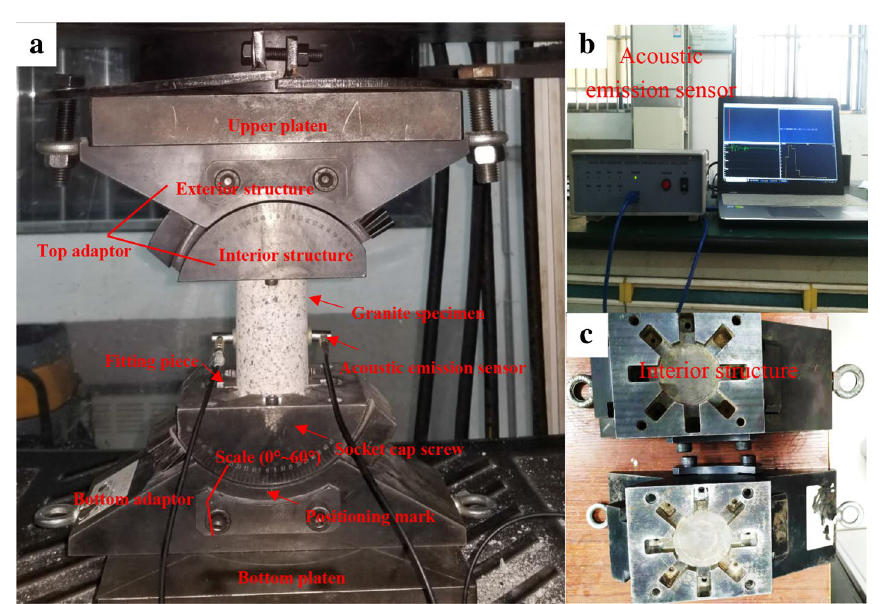
Figure 17. C-CAST system adapter and its specimen end